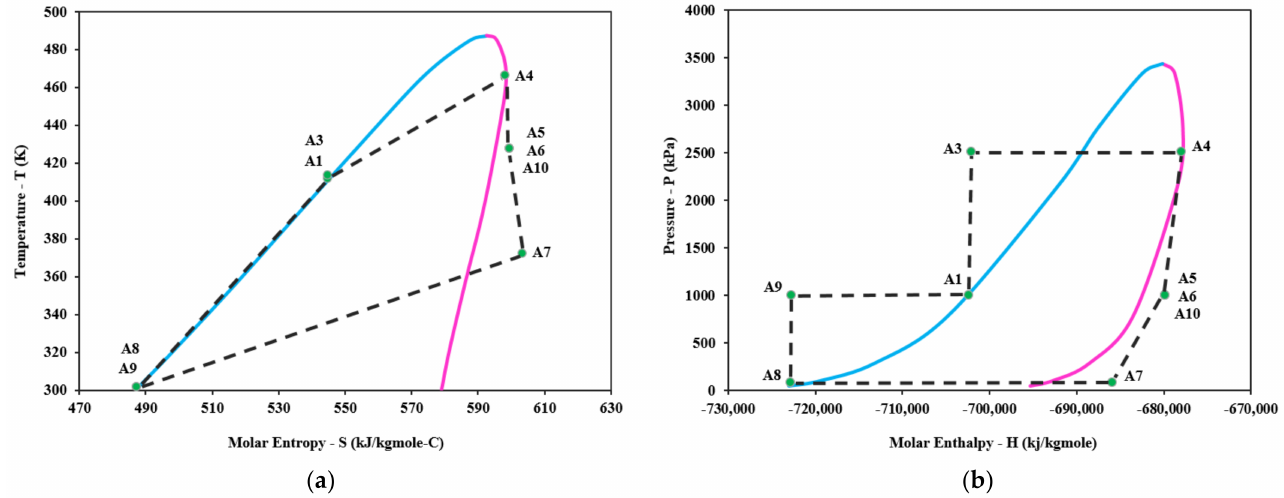
Figure 6. The organic Rankine power generation cycle: ( a ) T-S diagram; ( b ) P-H